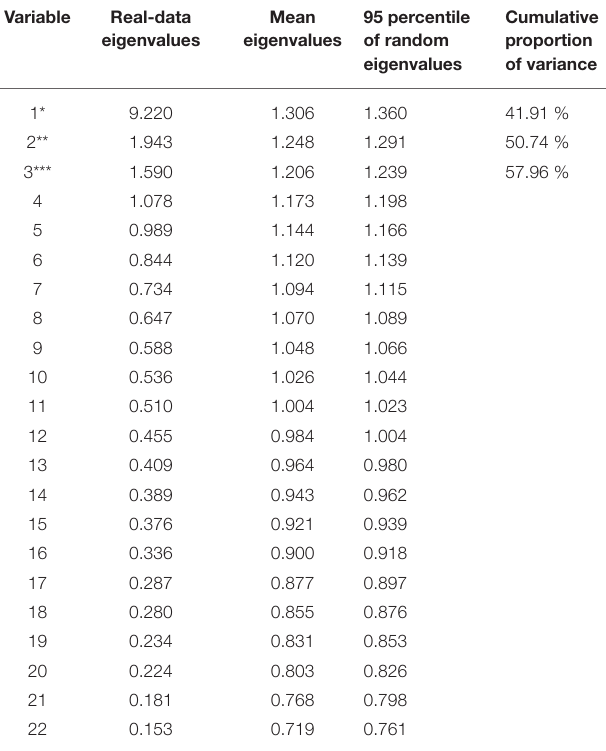
TABLE 7 | PCA based on polychoric correlations.